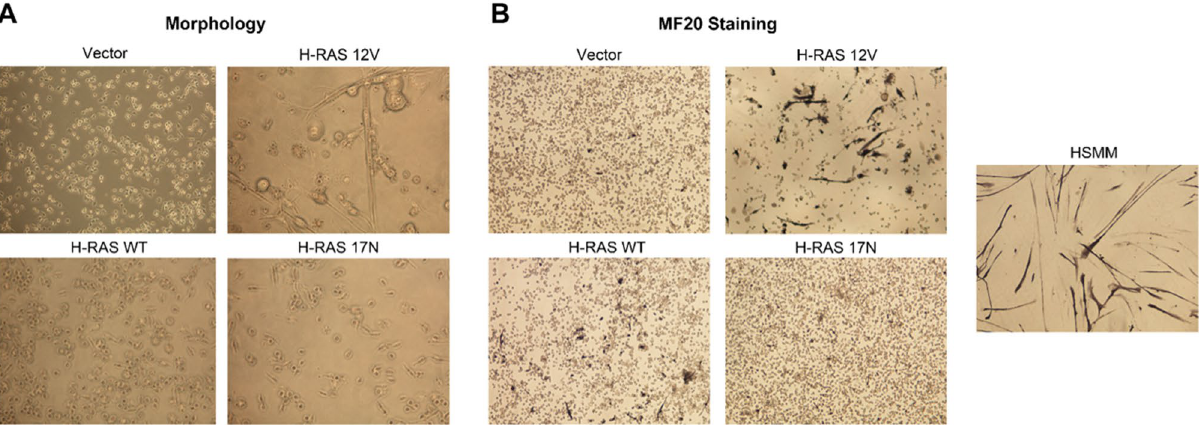
Figure 3. Expression of oncogenic H-RAS increases myogenic differentiation in Rh28 aRMS cells. ( A ) Under light microscopy, cells expressing oncogenic H-RAS 12V displayed an elongated morphology reminiscent of differentiating myotubes. ( B ) To assess for markers of differentiation, Rh28 cells expressing H-RAS mutants were cultured in differentiation media and stained for the myogenic marker sarcomere myosin using the anti- sarcomere-myosin hybridoma MF20. Representative images are shown (magnification ×100). Cells expressing oncogenic H-RAS show increased staining. However, when compared to the positive control HSMMs, cells expressing oncogenic RAS did not display the same degree of elongation and myotube formation. HSMM, human skeletal muscle